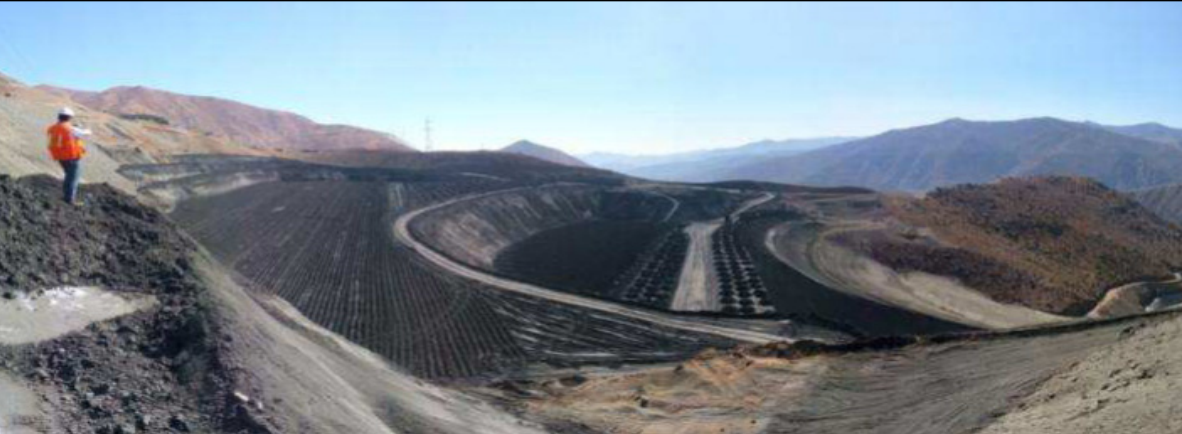
Figure 55. Cerro Lindo Filtered TSF Overview [20,21,25].